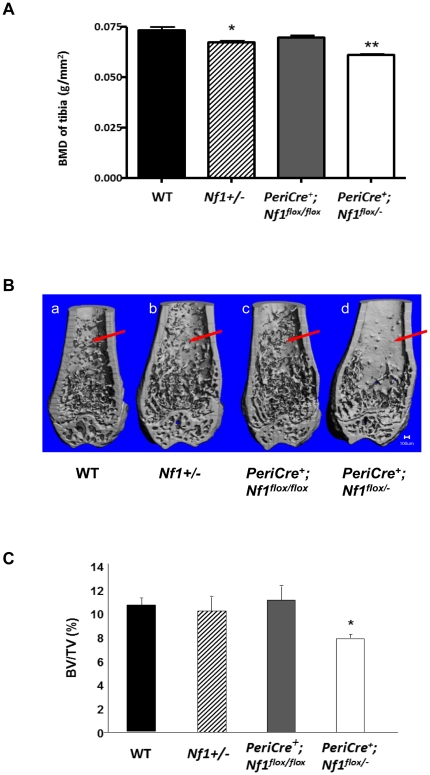
Loss of Nf1 results in reduced bone mineral density (BMD), volume (BV), and trabecular architecture in vivo.(A) pDEXA scans on 4–6-month-old mice revealed a 22% reduction of whole body BMD in PeriCre+;Nf1flox/− mice as compared to the other 3 genotypes of mice (n≥9/group, * and ** P<0.05). (B) μCT scans through the distal femur of 16-wk old mice revealed a significant reduction of trabecular bone volume in the PeriCre+;Nf1flox/− mice. The anterior portion of each femur had been removed for the metaphyseal architecture analysis. Red arrows indicate the deficiency in the trabecular network in the PeriCre+;Nf1flox/− mice vs. controls. (C) Quantitation of the trabecular bone volume reveals an ∼22% reduction of bone volume per unit total volume (BV/TV) in the distal femoral metaphysis of PeriCre+;Nf1flox/− mice as compared to the other genotypes (n = 4–6/group, * and ** P<0.05).